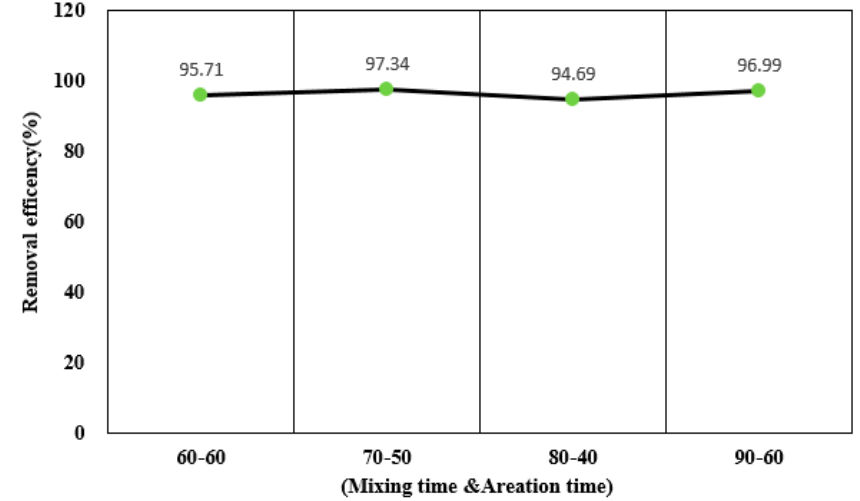
Figure 8. Changes in removal efficiency based on changes in mixing: aeration times (T-N).